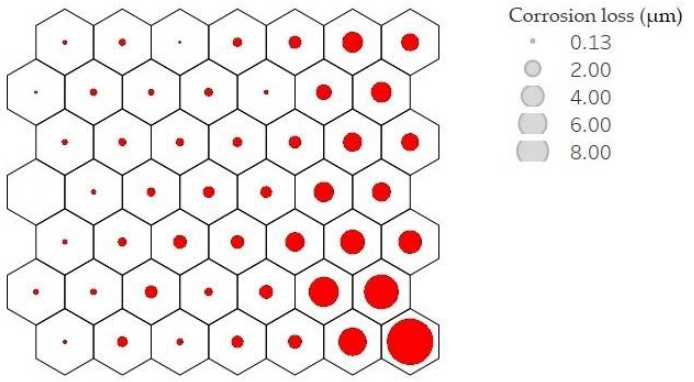
Figure 9. Mean corrosion values per neuron. Corrosion loss in µm per year is represented by circle size.